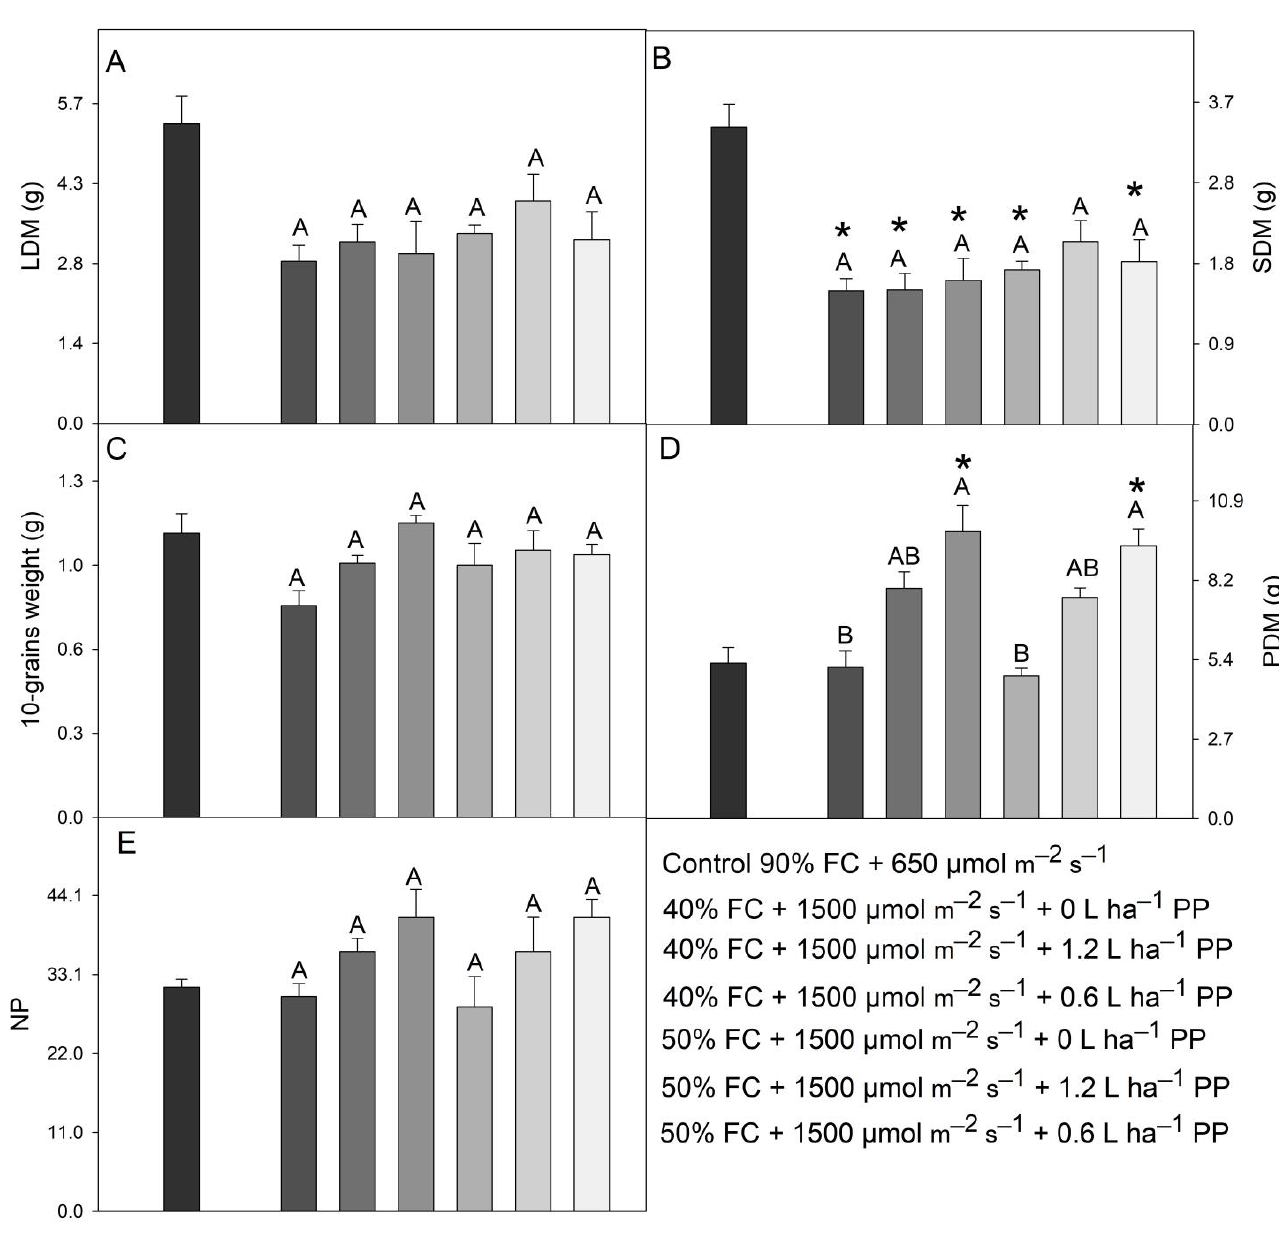
Figure 7. Leaf dry matter (LDM g; ( A )), stem dry matter (SDM g; ( B )), 10-grains weight (g; ( C )), pod dry matter (PDM g; ( D )), num € of pods (NP; ( E )) of soybean plants treated with doses of potassium phosphite (PP) and exposed to water deficit + high irradiance for 12 days. Bars represent mean ± SEM ( n = 5). Means followed by an asterisk (*) differ from control by Dunnett’s test ( p < 0.05). Means followed by the same letter did not differ among stress treatments, as determined by Tukey’s test ( p < 0.05).